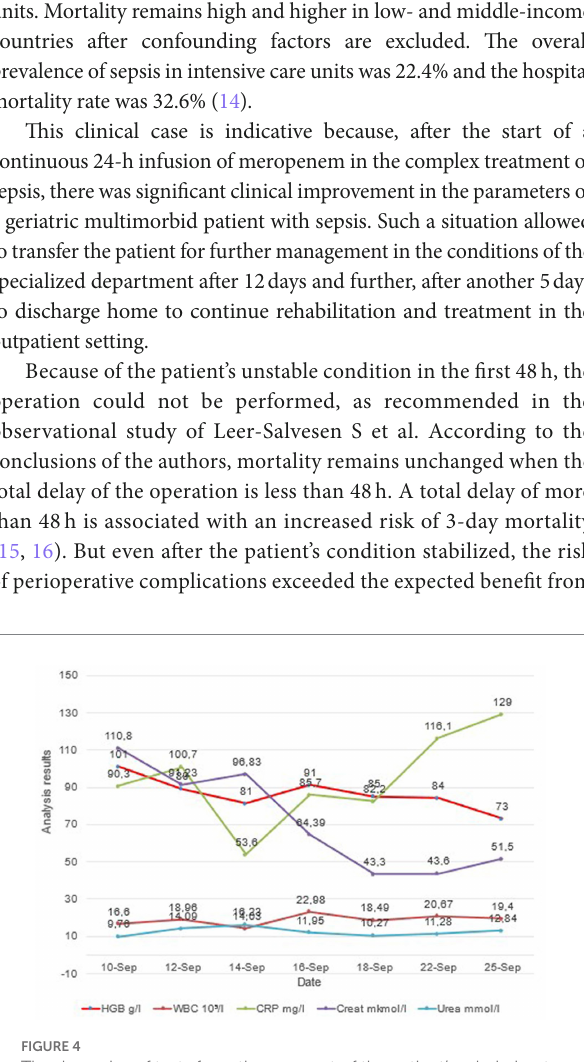
FIGURE 3 The dynamics of the patient’s respiratory function indicators.